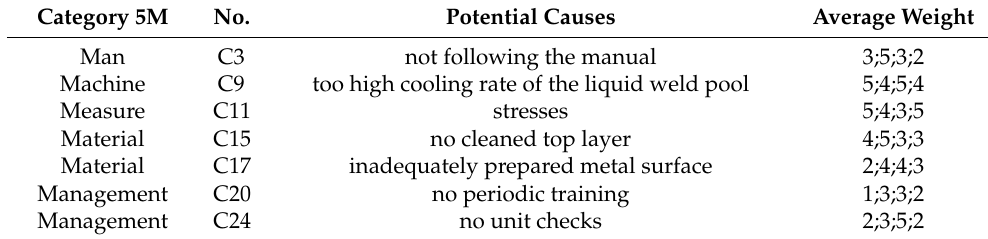
Figure 6. Ishikawa diagram for crack on the outer hull of four-point bearing to choose the second- order causes. Table 3. Assessment of weights of second-order causes.